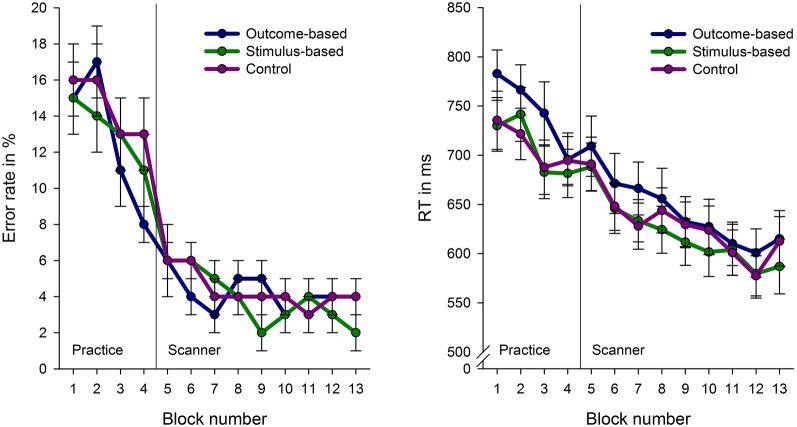
Error rates and response times (RT) for the experimental conditions across the course of the experiment. Each block comprises 16 trials with the exception of block 1 which consist of 32 trials. Error bars indicate standard errors.